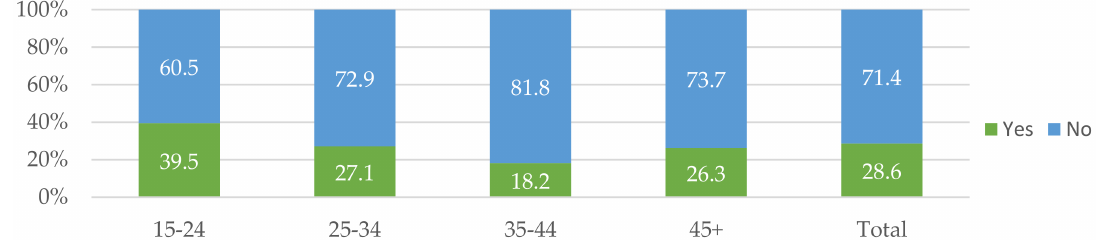
Figure 6. Sexual violence by age groups